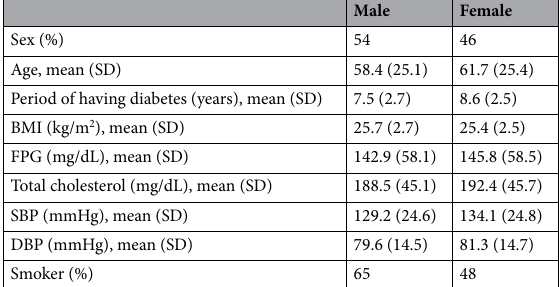
Table 5. Statistics of filtered diabetes patients in the dataset.